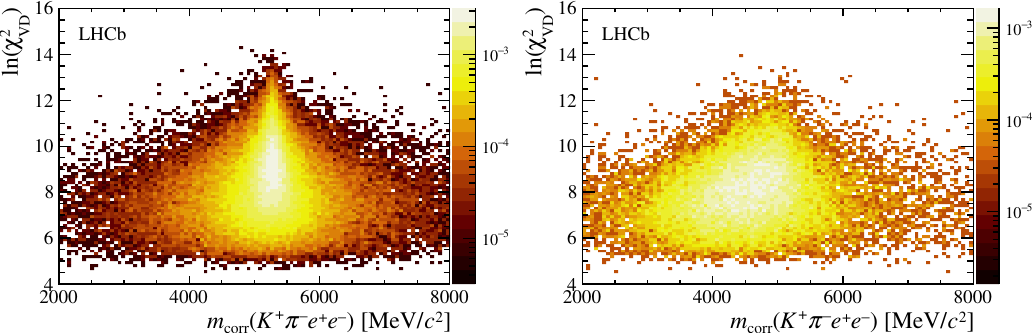
Figure 4 . Distribution of (cid:31) 2 as a function of m corr for (left) B 0 ! K (cid:3) 0 e + e (cid:0) and (right) VD B ! X ( ! Y K (cid:3) 0 ) e + e (cid:0) simulated candidates. The distributions are normalised to the same number of